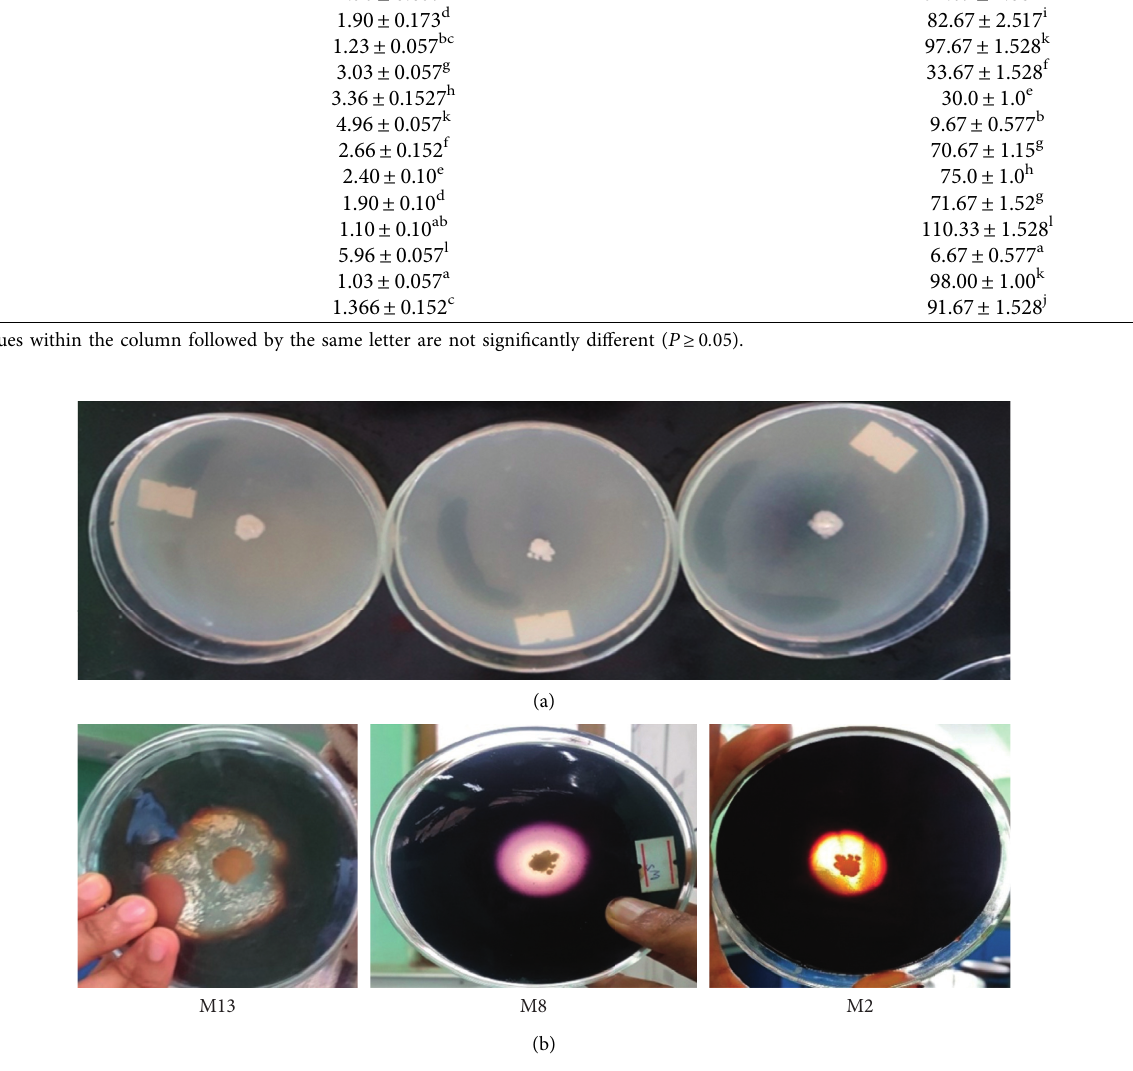
Figure 1: Zone of hydrolysis of starch by the three selected isolates before (a) and after (b) the addition of iodine solution. Table 2: Morphological characterization of bacterial